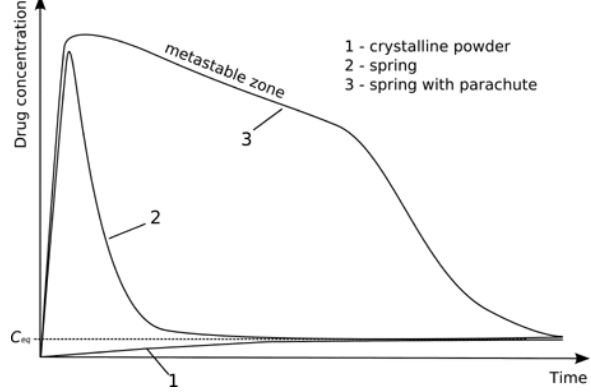
Figure 10. Illustration of non-sink conditions used in the dissolution test. Dissolution profile 1: dissolution of the crystalline API ; profile 2: dissolution of a “spring” effect of the API without the presence of dissolution enhancers profile 3: dissolution of a “spring” and ‘’parachute” form of the API in the presence of dissolution enhancers act as a “parachute.” C eq represents equilibrium solubility.